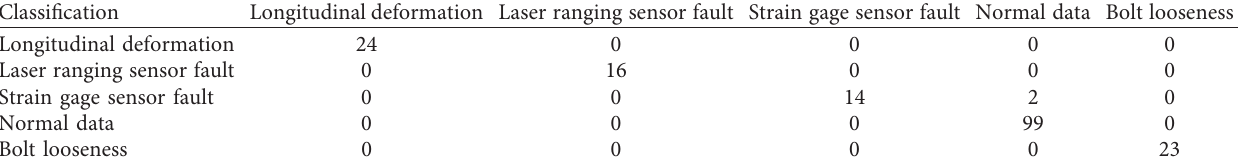
Table 7: Confusion matrix of